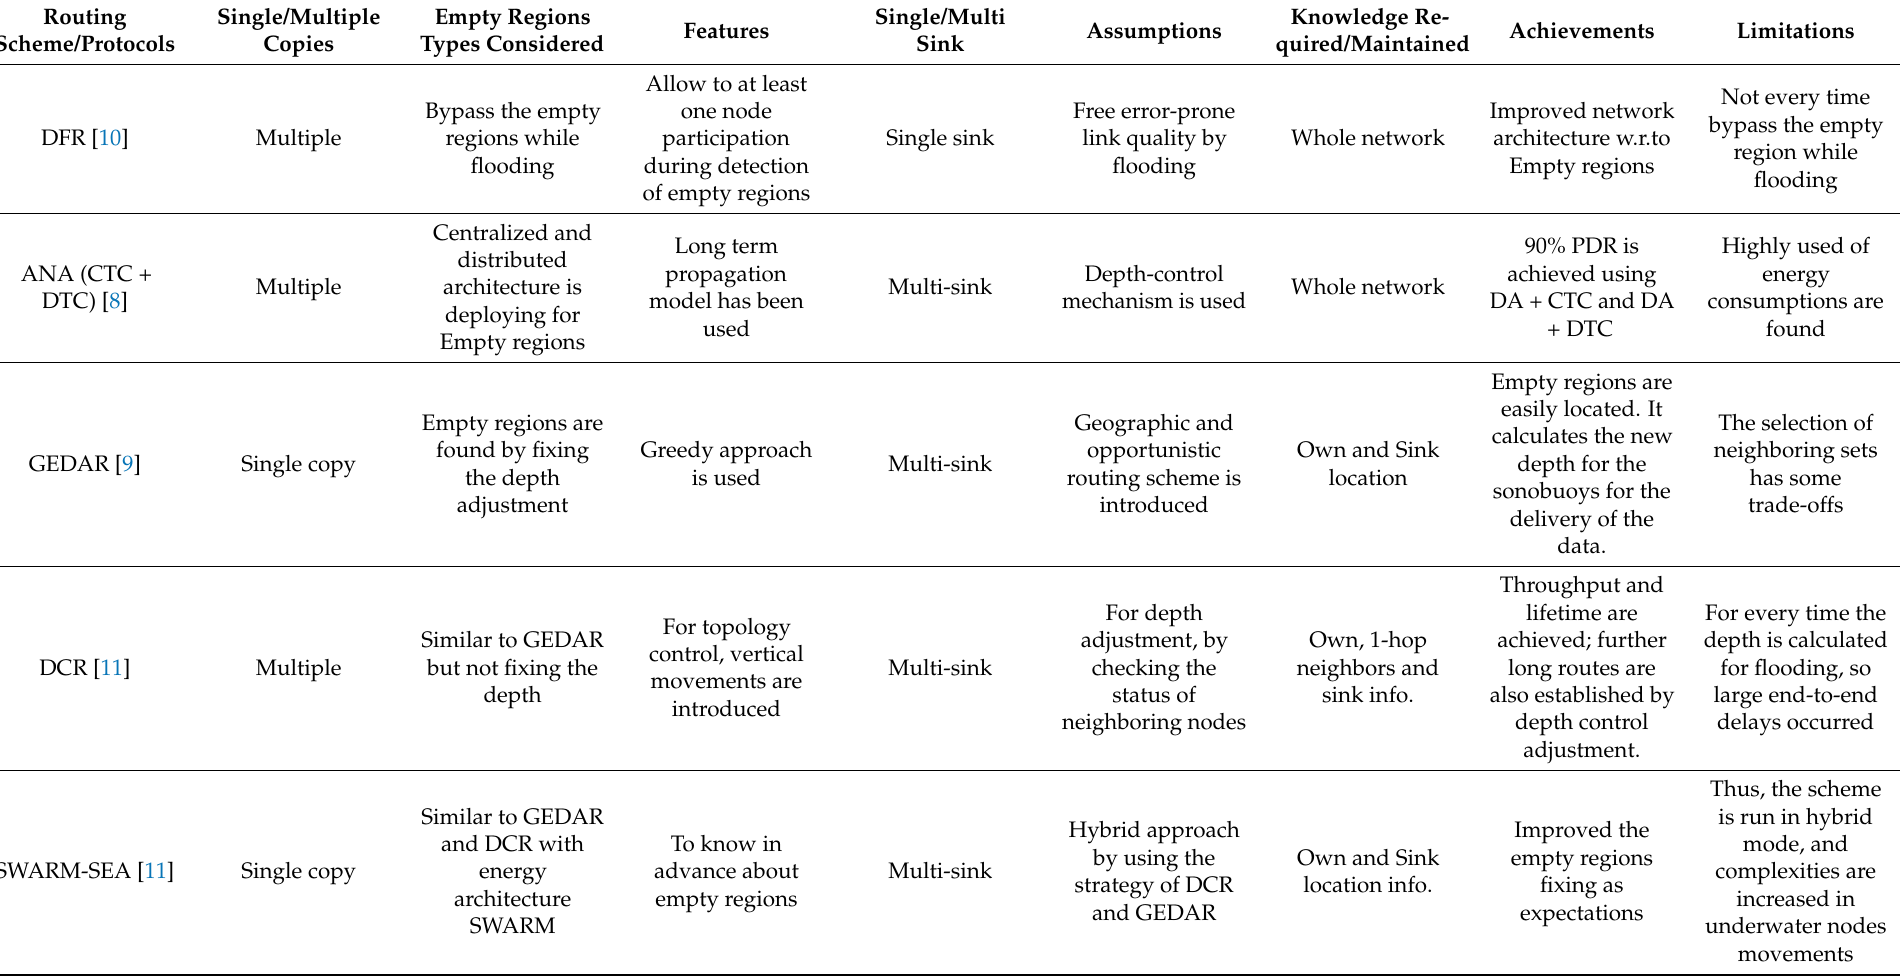
Table 1. Summary of possible Underwater Acoustic Sensor Network routing schemes as discussed in related